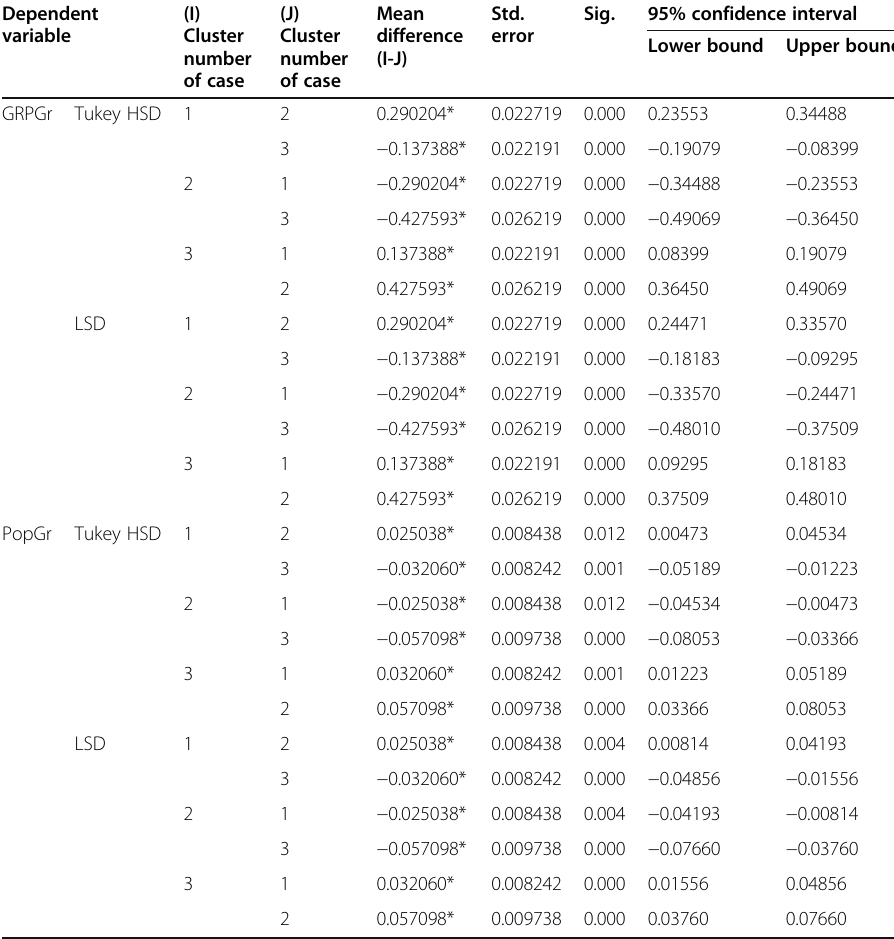
Table 9 Post hoc tests of cluster means from k-means clustering, multiple